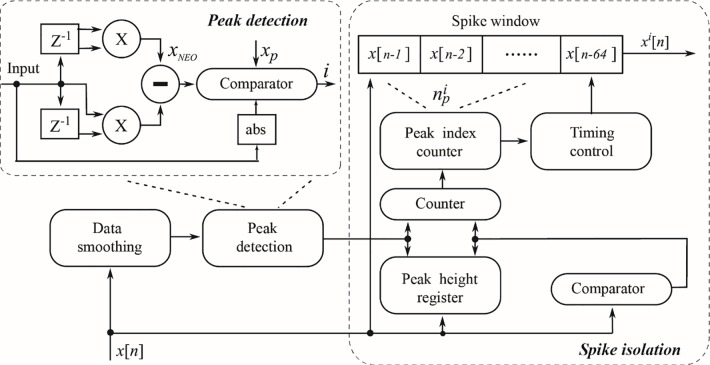
A block diagram illustrating the hardware implementation of the spike detection and isolation.An 8-sample smoothing filter was used to remove high frequency noise from the input neuron signal, followed by a peak detection module based on the NEO algorithm to detect a neural spike for isolation. A 64-sample FIFO was used to temporarily store the isolated data stream. A peak index counter and a peak height register worked synergistically to determine the peak index to correctly isolate the neural spike maximum. A 32-sample neural spike arrays centering against the spike peak center were outputted from the module for downstream feature extraction.